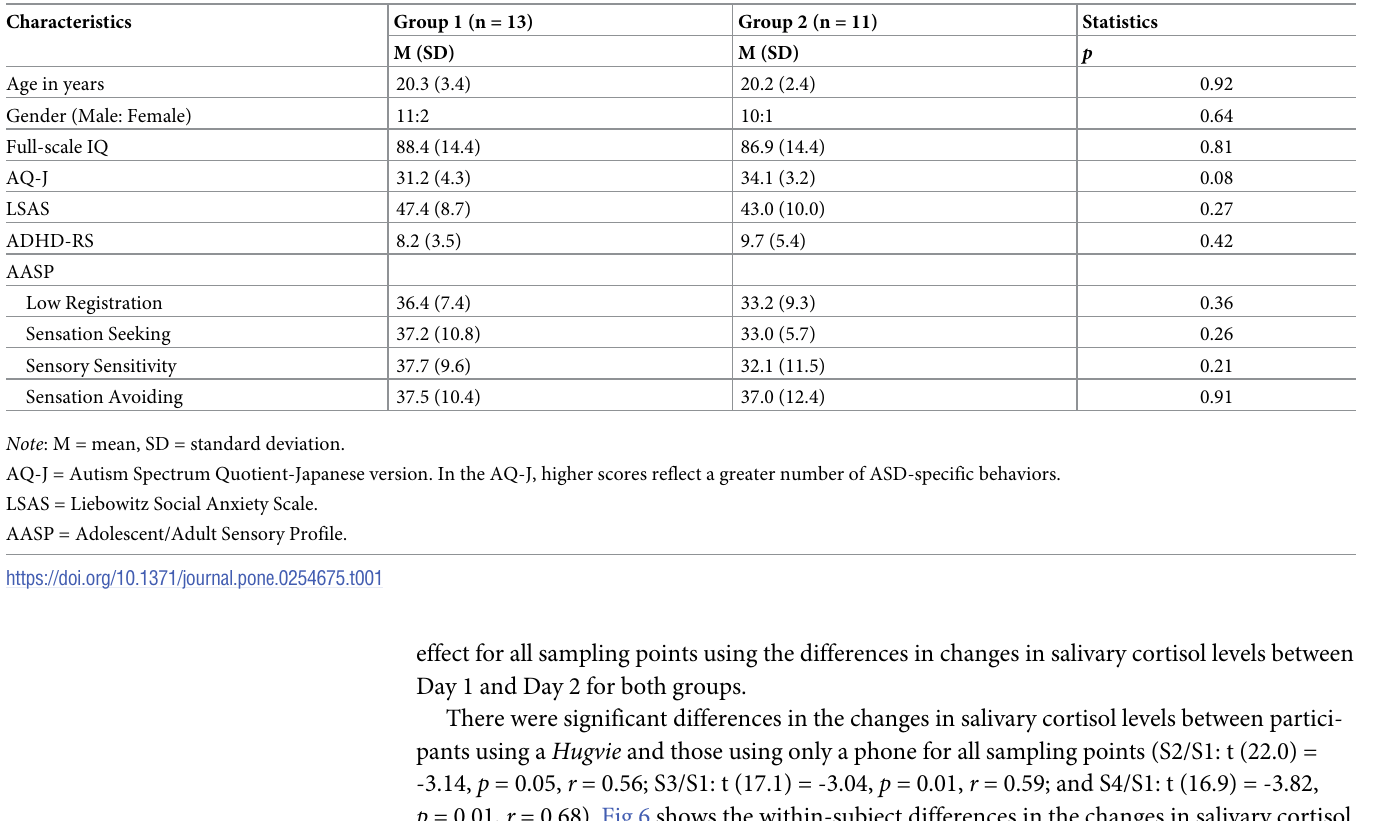
Table 1. Descriptive statistics of participants in group 1 and group 2 (n = 24).